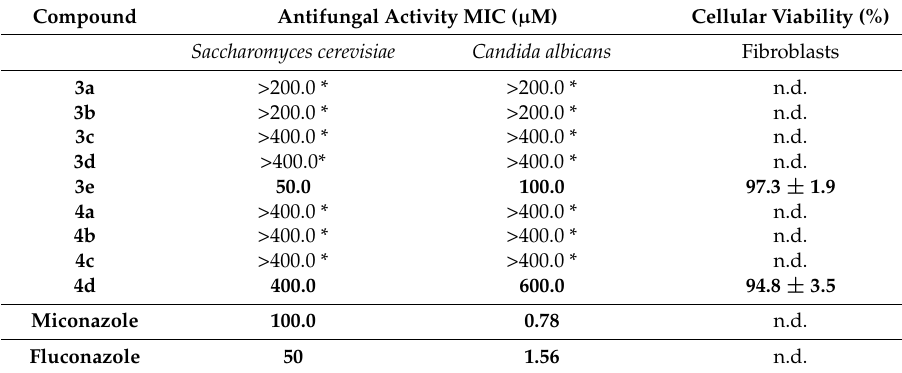
Table 3. Values of minimum inhibitory concentration (MIC) on yeast and the viability of fibroblasts at the indicated concentrations of the